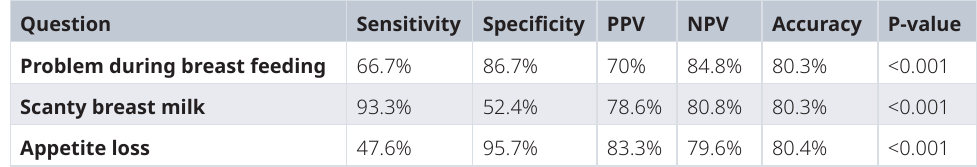
Table 3. Validation with anthropometric measures of the questions which have the highest sensitivity, specificity and accuracy by the SGA.